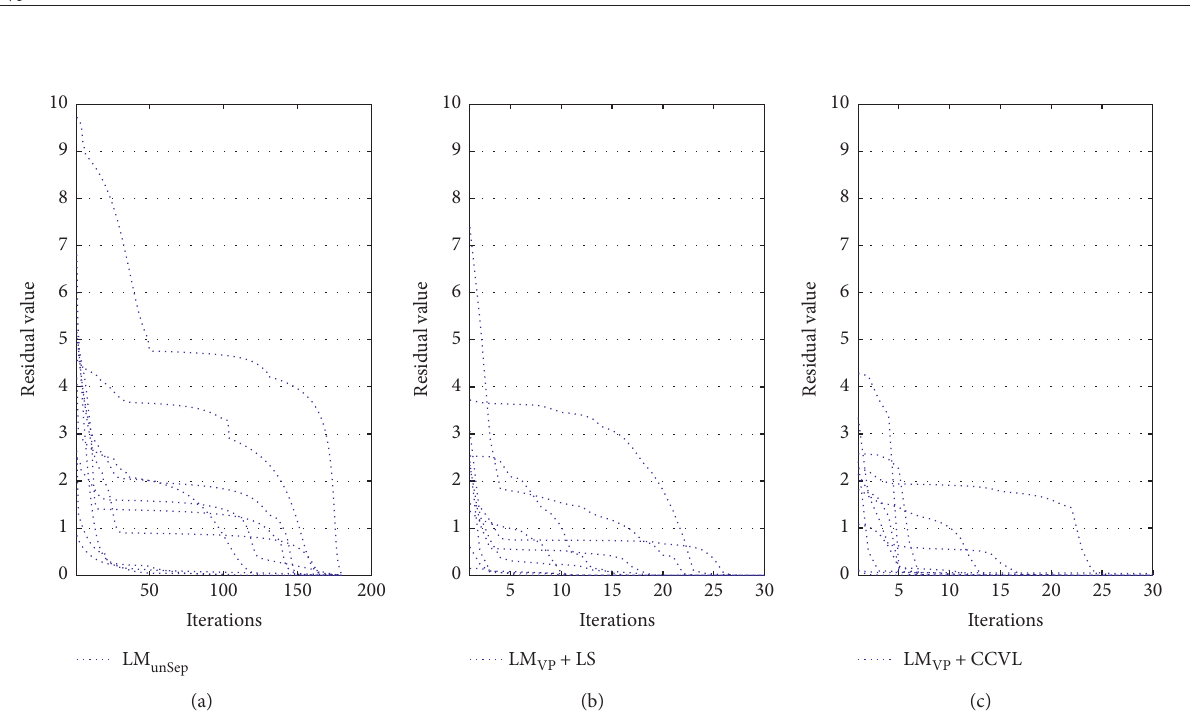
Figure 7: Residual changes of the three methods in the iteration process of Example